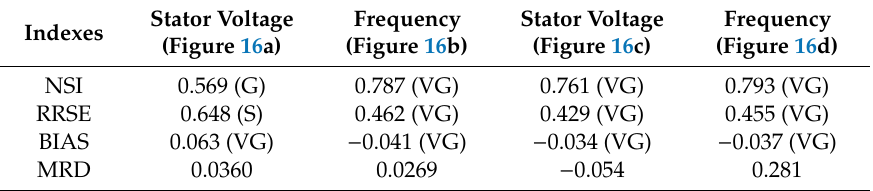
Table 6. Error indexes for the compared